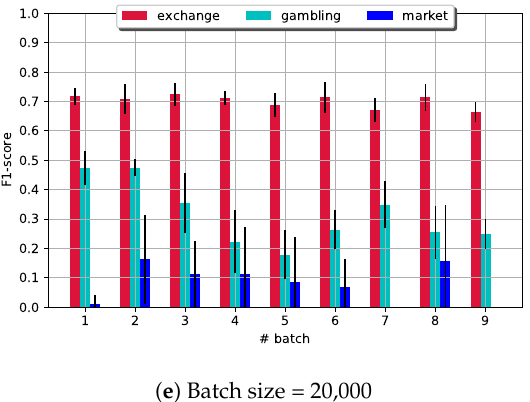
Figure 5. F1-score computed in the four presented experiments with different batch_size for Exchange, Gambling, and Market